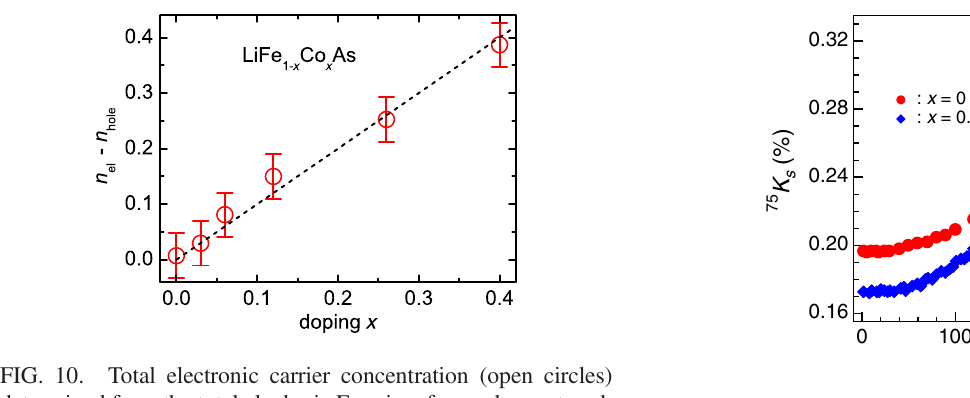
energy spin fluctuations are captured by the spin-lattice relaxation rate 1 =T 1 T .